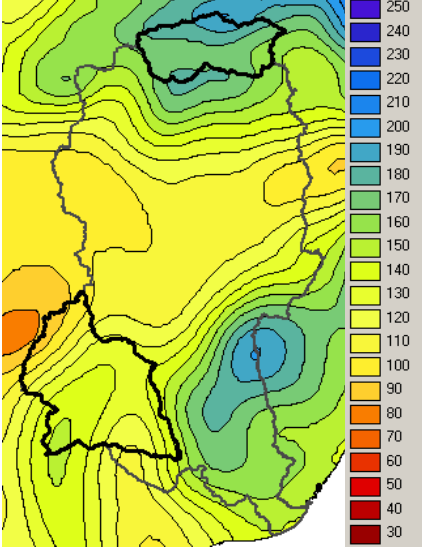
Figure 2 Daily maximum precipitation (in mm) for a 100-year return period, showing the 2 Fig. 2. Daily maximum precipitation (in mm) for a 100yr return period, showing the Llobregat, Alt Llobregat and Anoia basins. Llobregat, Alt Llobregat and Anoia basins. Source: Casas et al. (2005). 3 Source: Casas et al. (2005).